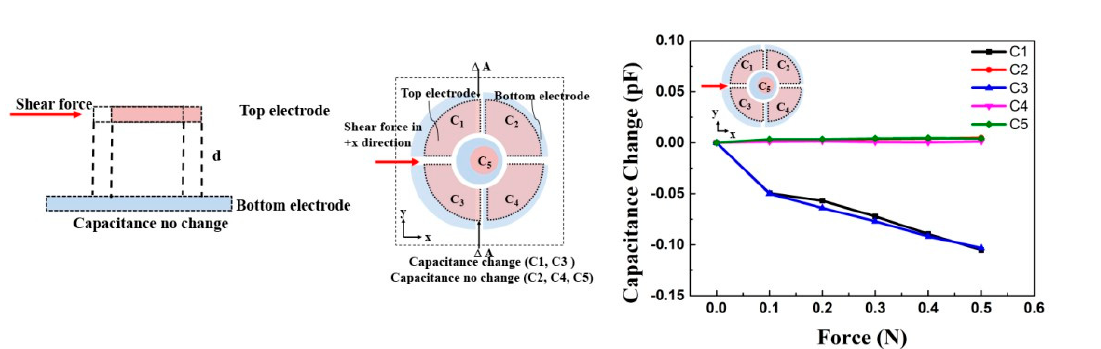
Figure 5. Schematic of ( a ) the sensing mechanism in shear force ( b ) the measured capacitance changes for the shear force in +x-direction.